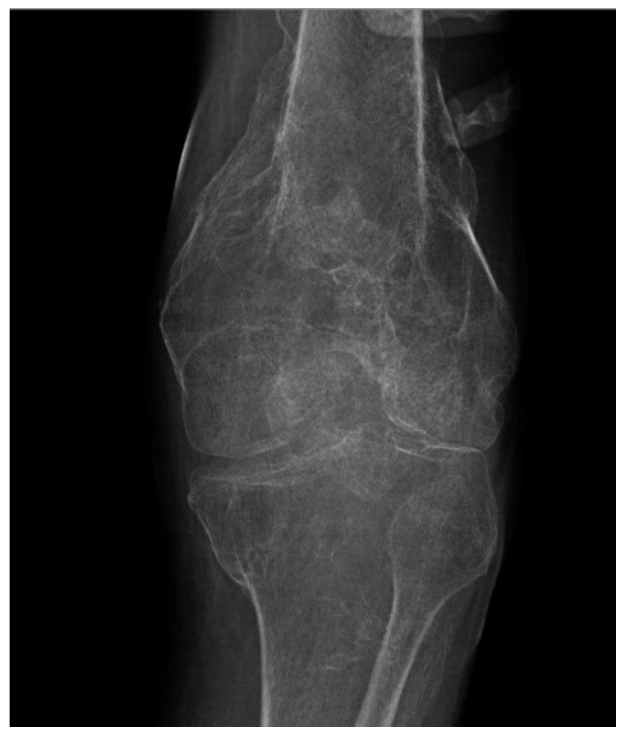
Figure 1 . Left knee x-ray (oblique, externally rotated). Diffuse bony demineralization reduces sensitivity of radiography for acute fracture. There is corticated deformity of the distal femur and proximal tibia from old, healed fractures. No clear evidence of a superimposed acute